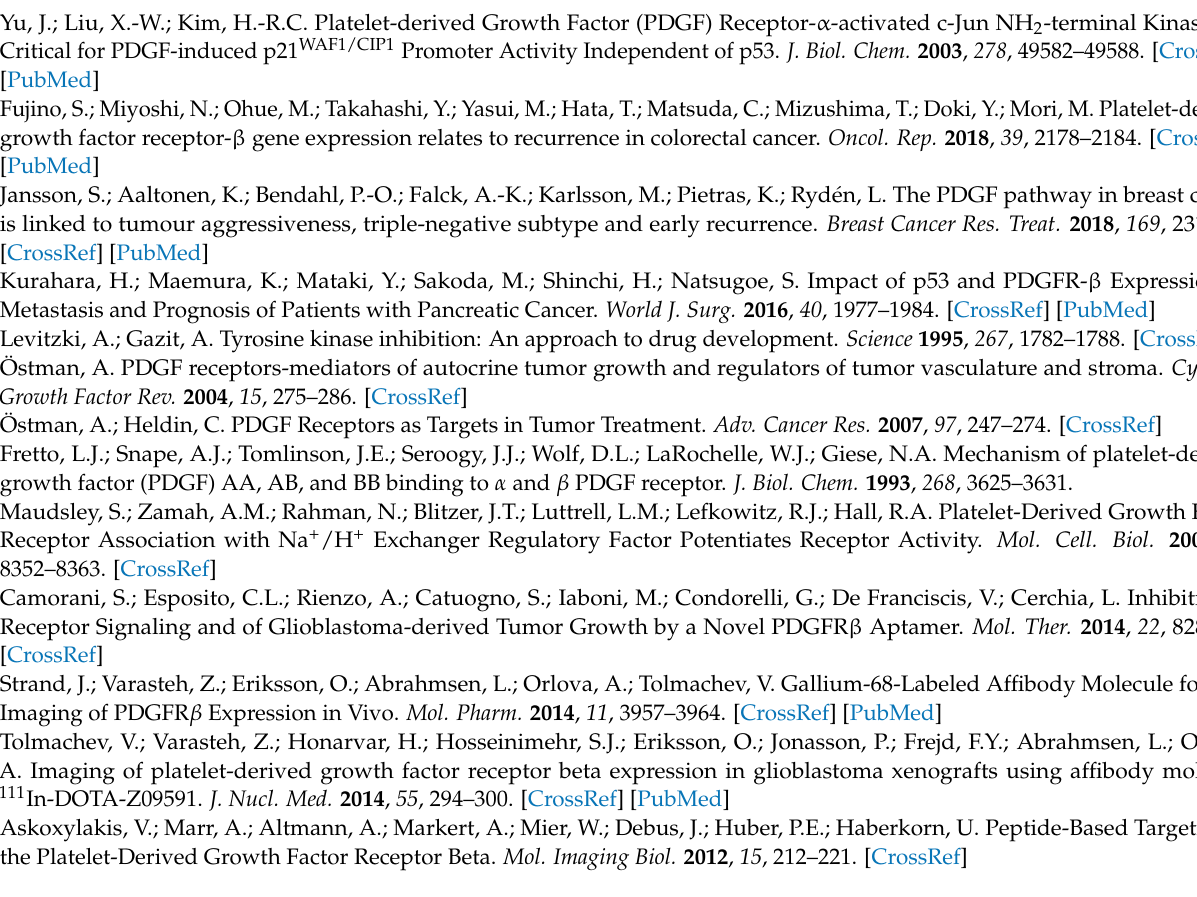
Supplementary Materials: The following are available online, Figure S1: The chromatogram of